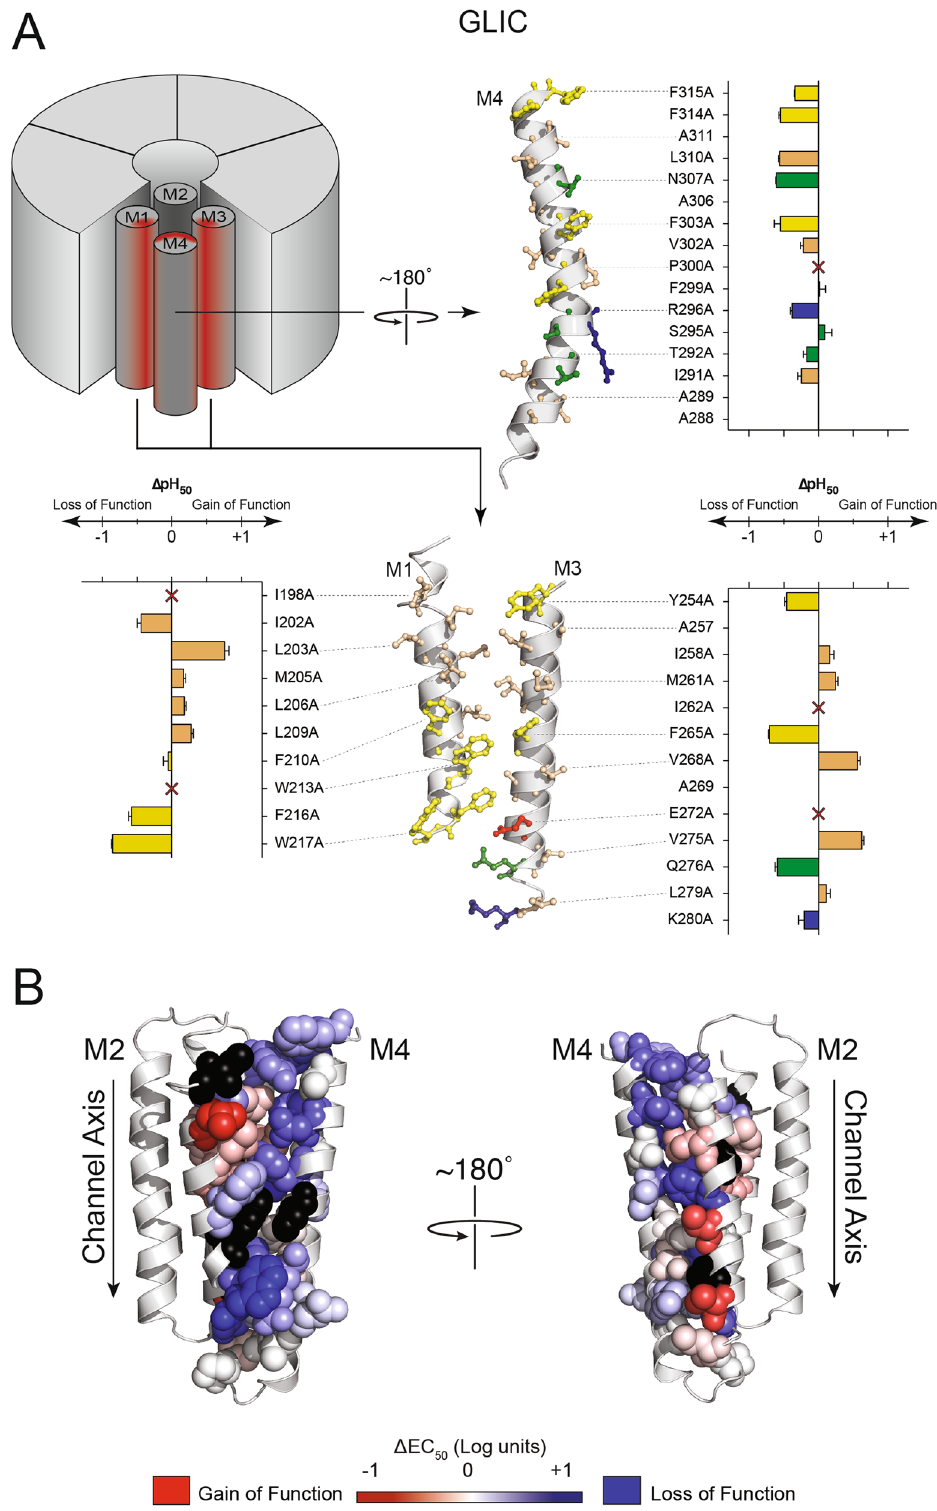
Figure 3. Functional effects of Ala mutations at the M4-M1/M3 interface in GLIC. ( A) Changes in the pH 50 resulting from Ala mutations of residues on M4 (top right panel), M1 (bottom left) and M3 (bottom right). Residues and bar graphs are colour-coded as in Fig. 1, with aliphatic residues tan. The bar graphs represent the magnitude of change ± the standard deviation. ( B) Changes in the pH 50 values are heat-mapped onto the GLIC structure (PDB: 4HFI). The magnitude of the shift in pH 50 is depicted via colour intensity, with no change in pH 50 in white, gain-of-function in red, and loss-of-function in blue. Mutants that failed to express and/or function are shown in